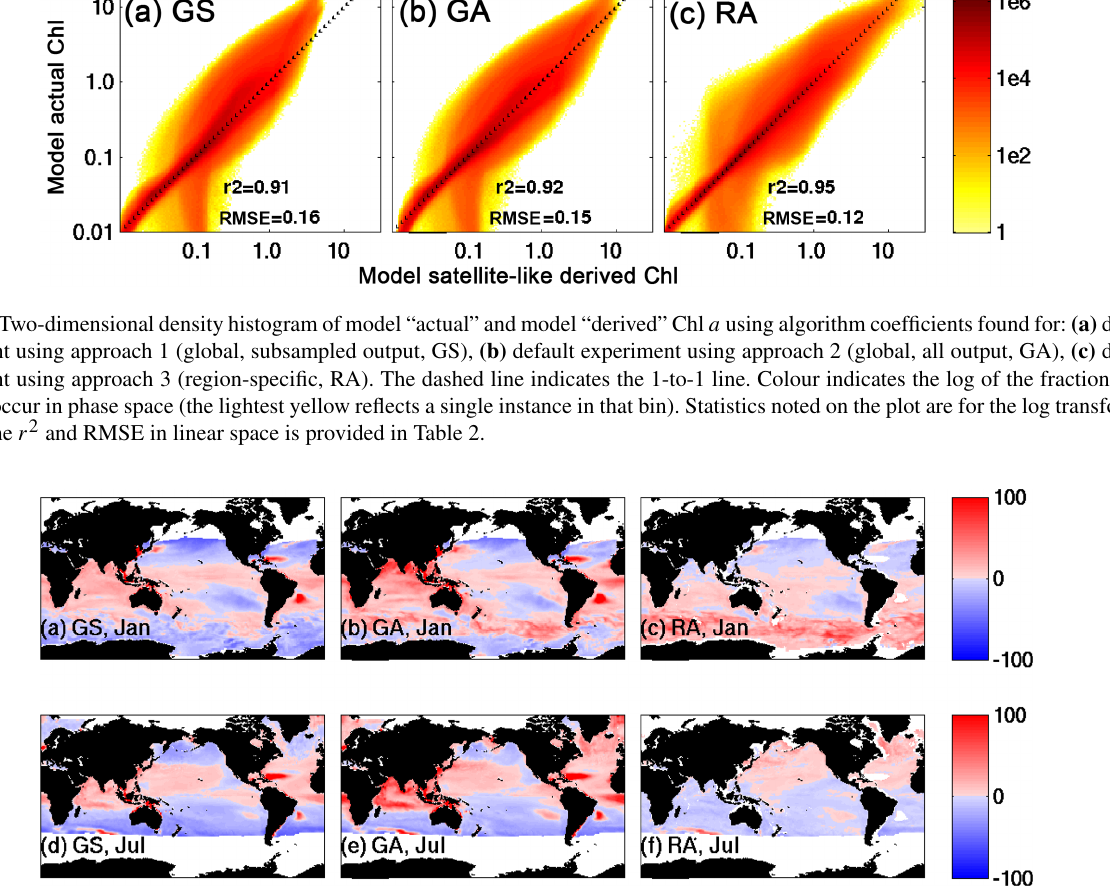
Figure 6. Percentage bias between monthly mean model “actual” Chl a and model “derived” Chl a (chl d ) using algorithm coefficients found for (a, d) subset of output (GS), (b, e) full model output (GA) and (c, f) each grid cell (region-specific, RA). The top row is for January and the bottom row is for July. White areas indicate the unresolved Arctic and regions where PAR is less than 15µEinm − 2 s − 1